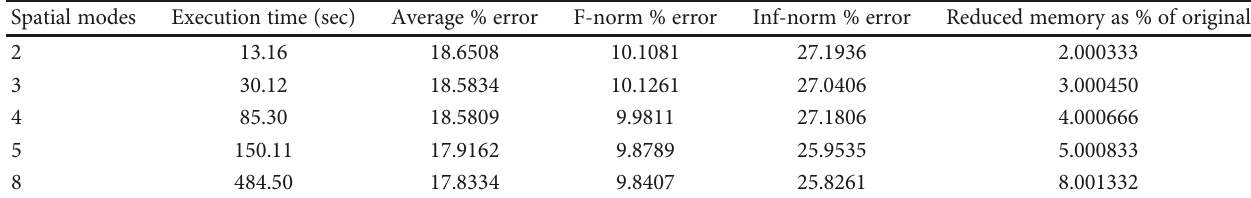
Table 14: Velocity in the x direction reduced 3D model over 100 time steps.